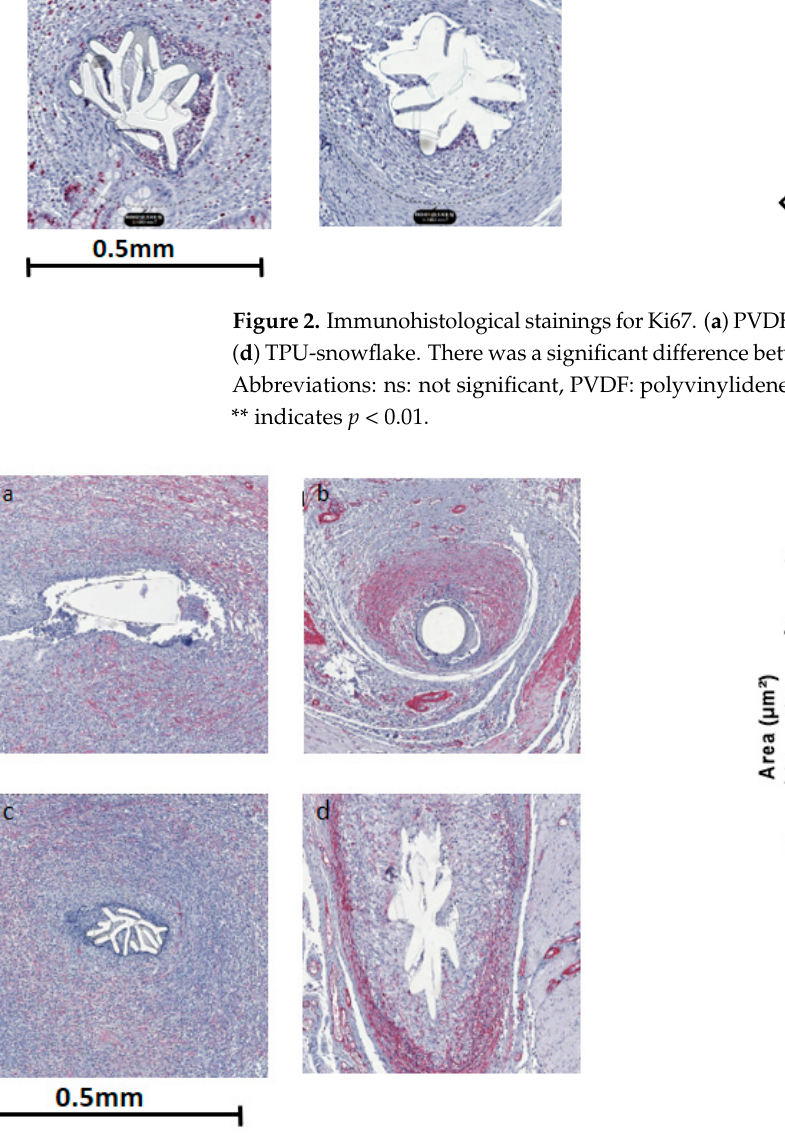
Figure 3. Immunohistological stainings for SMA. ( a ) PVDF-round, ( b ) TPU-round, ( c ) PVDF-snowflake, ( d ) TPU-snowflake. There was a significant difference between the groups (F (3, 66) = 5.884, p = 0.0013). Abbreviations: ns: not significant, PVDF: polyvinylidene fluoride, TPU: thermoplastic polyurethane, SMA: smooth muscle actin; * indicates p < 0.05, *** indicates p < 0.001.